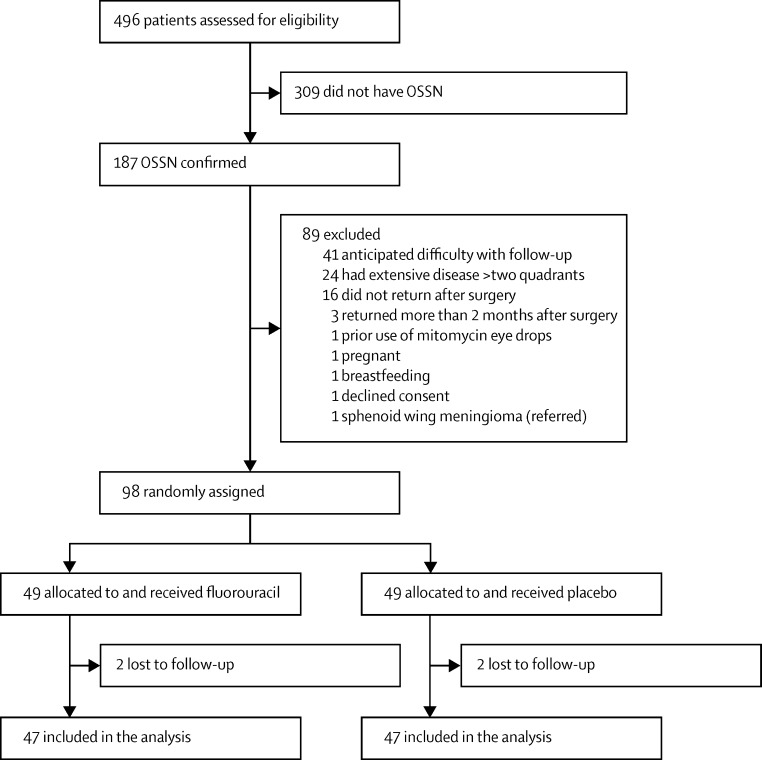
Trial profileOSSN=ocular surface squamous neoplasia.